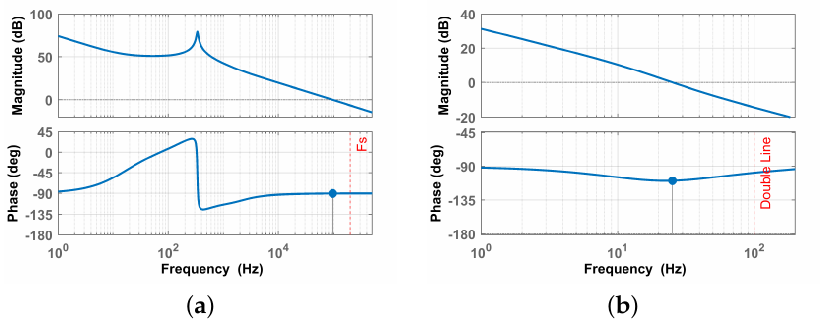
Figure 15. Bode plots transfer functions for buck loop gain of: ( a ) Current loop Gi L 1 d _ d _ RC ( s ) G Ci ( s ) . ( s ) G ( s ) K sense ( b ) Voltage loop G vi CV ref